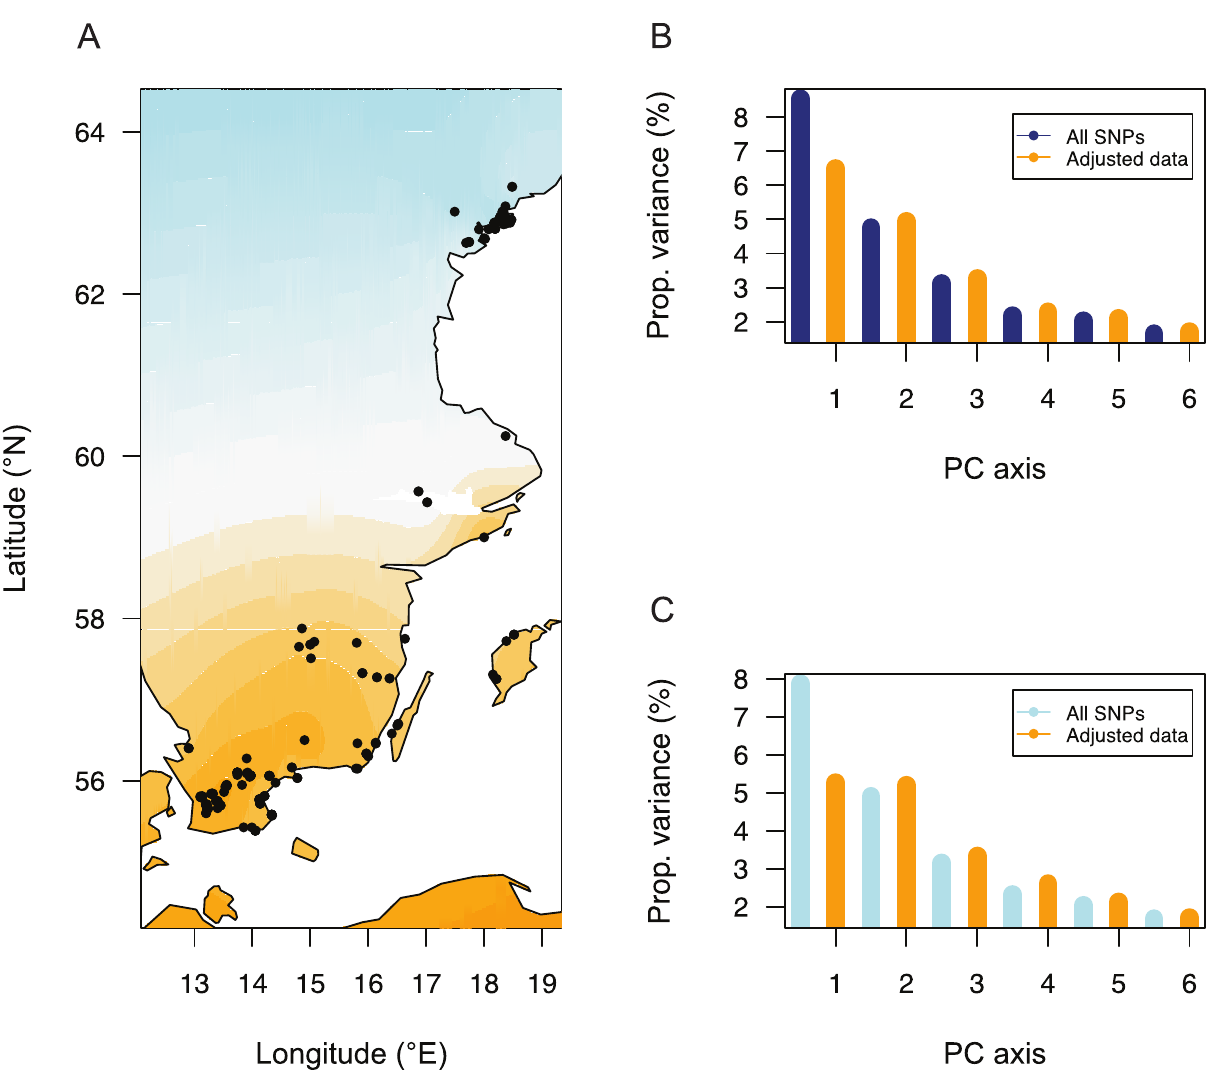
Fig 6. Neutral F ST for Arabidopsis thaliana in Scandinavia. ( A ) Geographic locations of 241 samples and inference of population structure from a spatial method (Blue color: Southern cluster, Orange color: Northern cluster). The map was generated by using the open source R package maps (CC-BY license), which loads data from www.naturalearthdata.com. ( B ) Proportion of variance explained by PC axes before adjustment of genotypes for bioclimatic variables (blue color) and after adjustment (orange color). ( C ) Proportion of variance explained by the first axis of the between- population matrix, and by the first axes of the residual matrix (five components) before adjustment for bioclimatic variables (blue color) and after adjustment (orange color). Wright’s coefficients are represented by the values for the first axis.